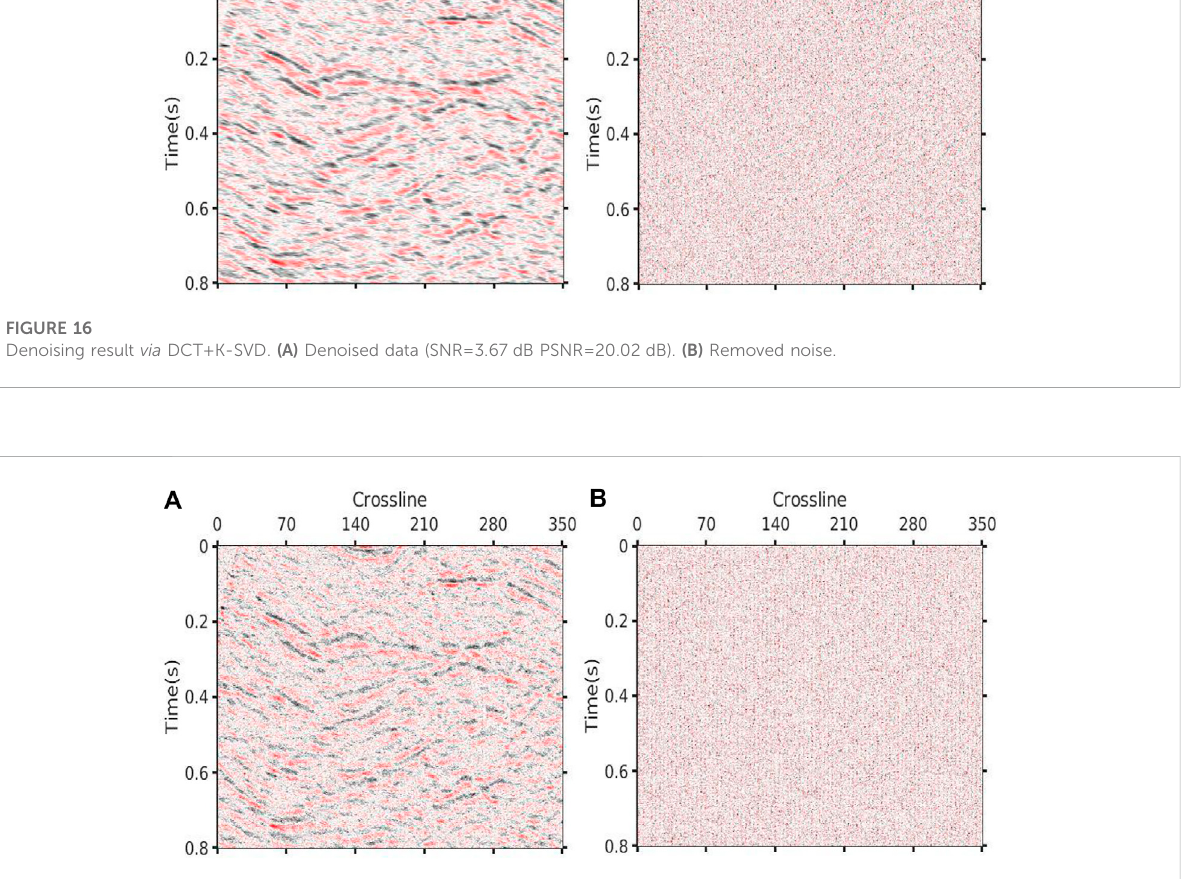
FIGURE 17 Denoising result via DCT. (A) Denoised data (SNR= − 1.19 dB PSNR=15.15 dB). (B) Removed noise.